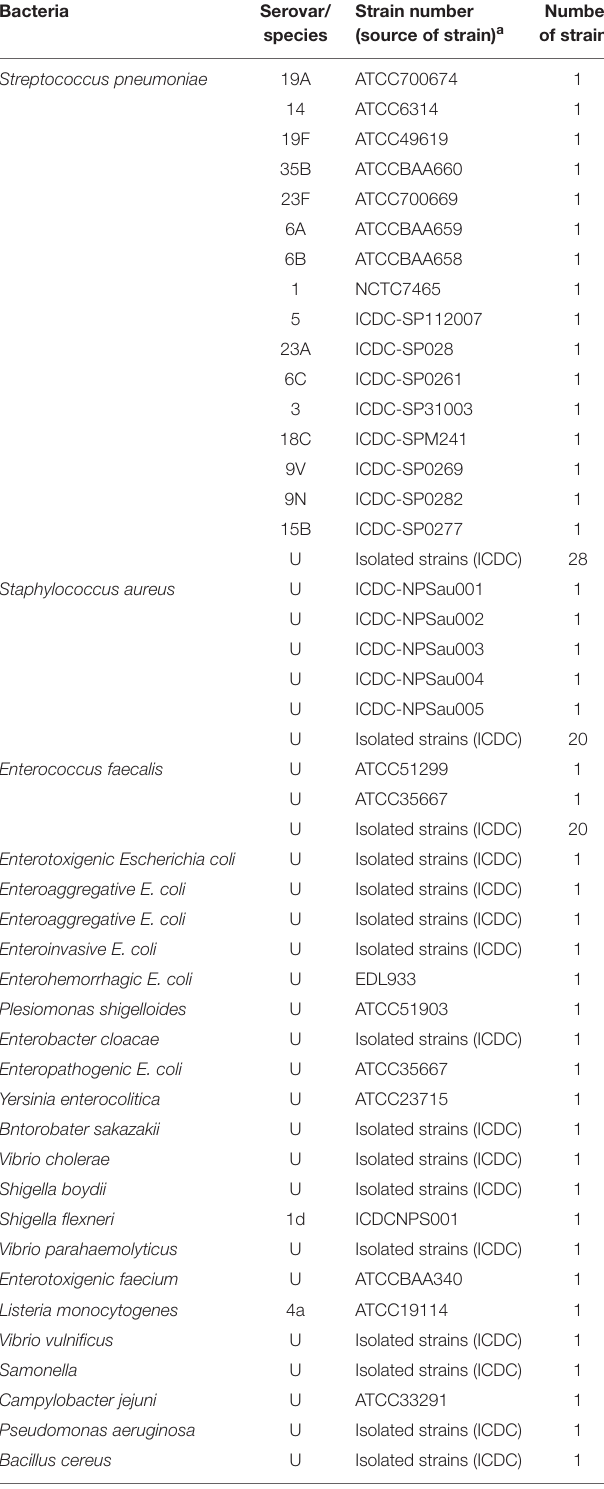
TABLE 2 | Bacterial strains used in this study. Bacteria Serovar/